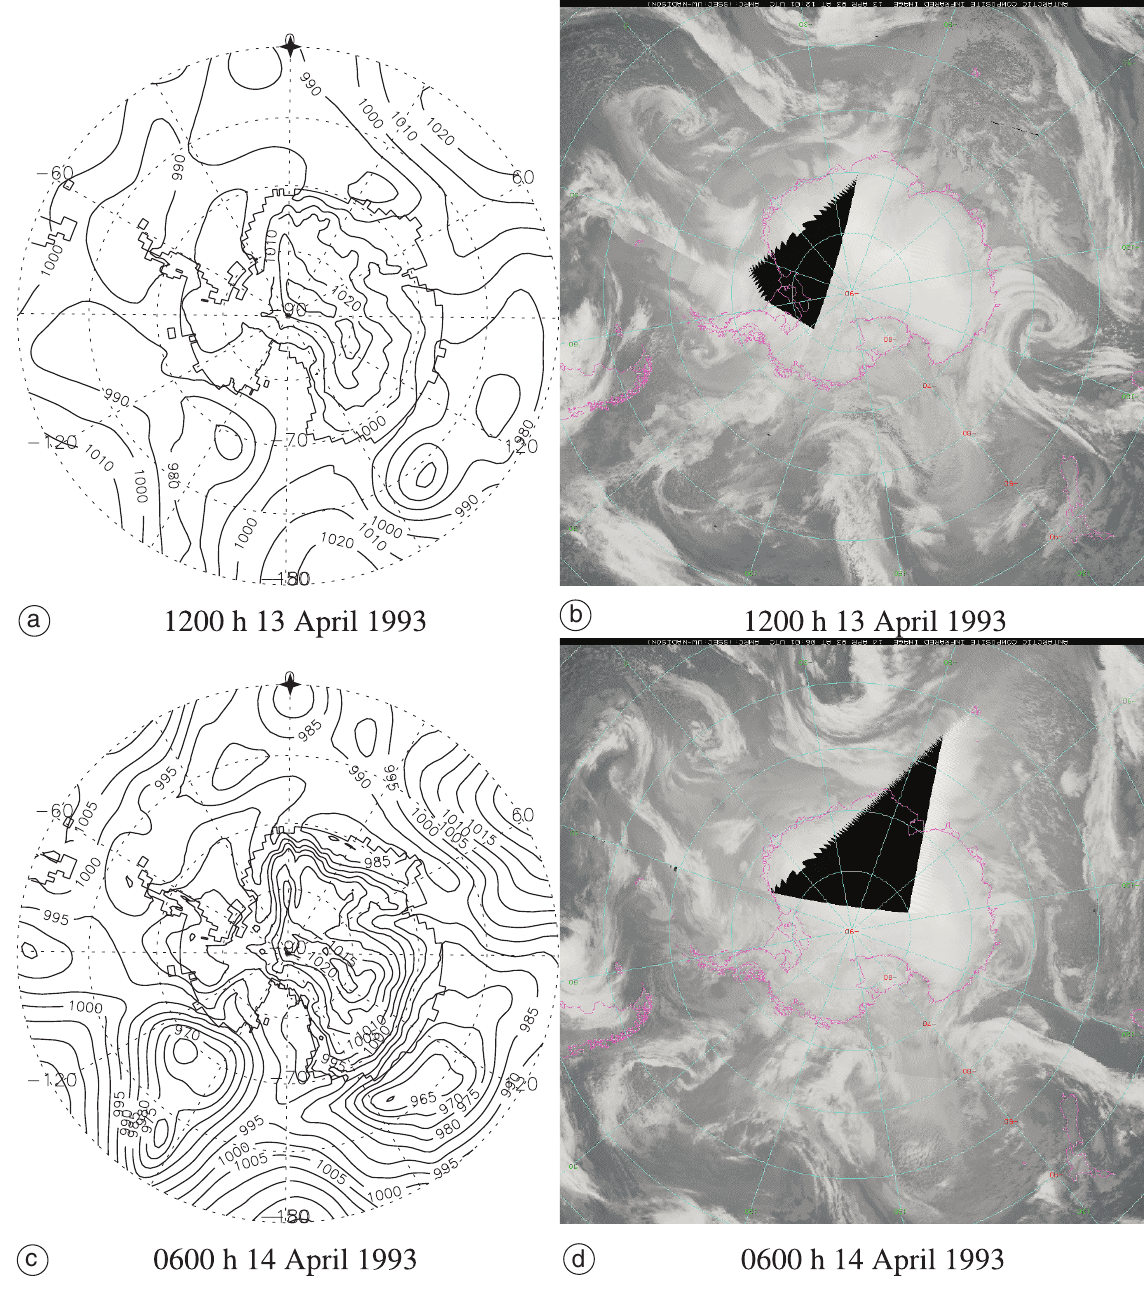
Fig. 3a-d. ECMWF analyses of mean sea level pressure charts and composite infrared satellite images for 1200 h 13 April (a,b) and 0600 h 14 April 1993 (c,d),